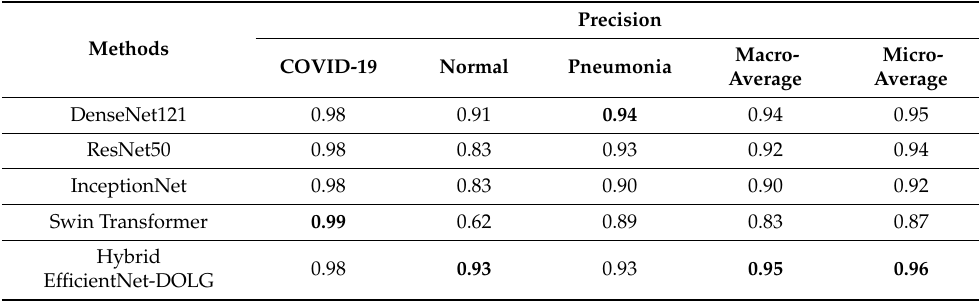
Table 4. Comparing results between the five deep learning models on the COVID-19 classification task with respect to precision metric